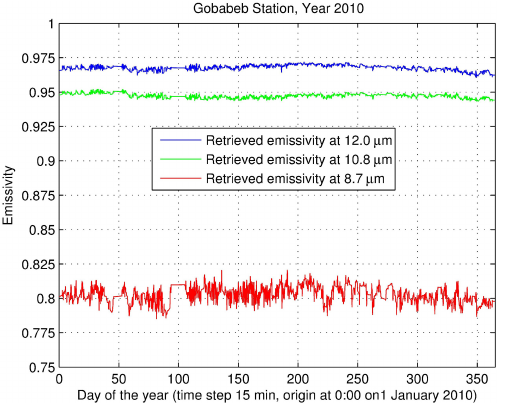
Figure 12. Gobabeb station. Emissivity retrieval. The retrieval has been smoothed with a moving-average filter with a time window of 3h. Retrievals refer to the year 2010.